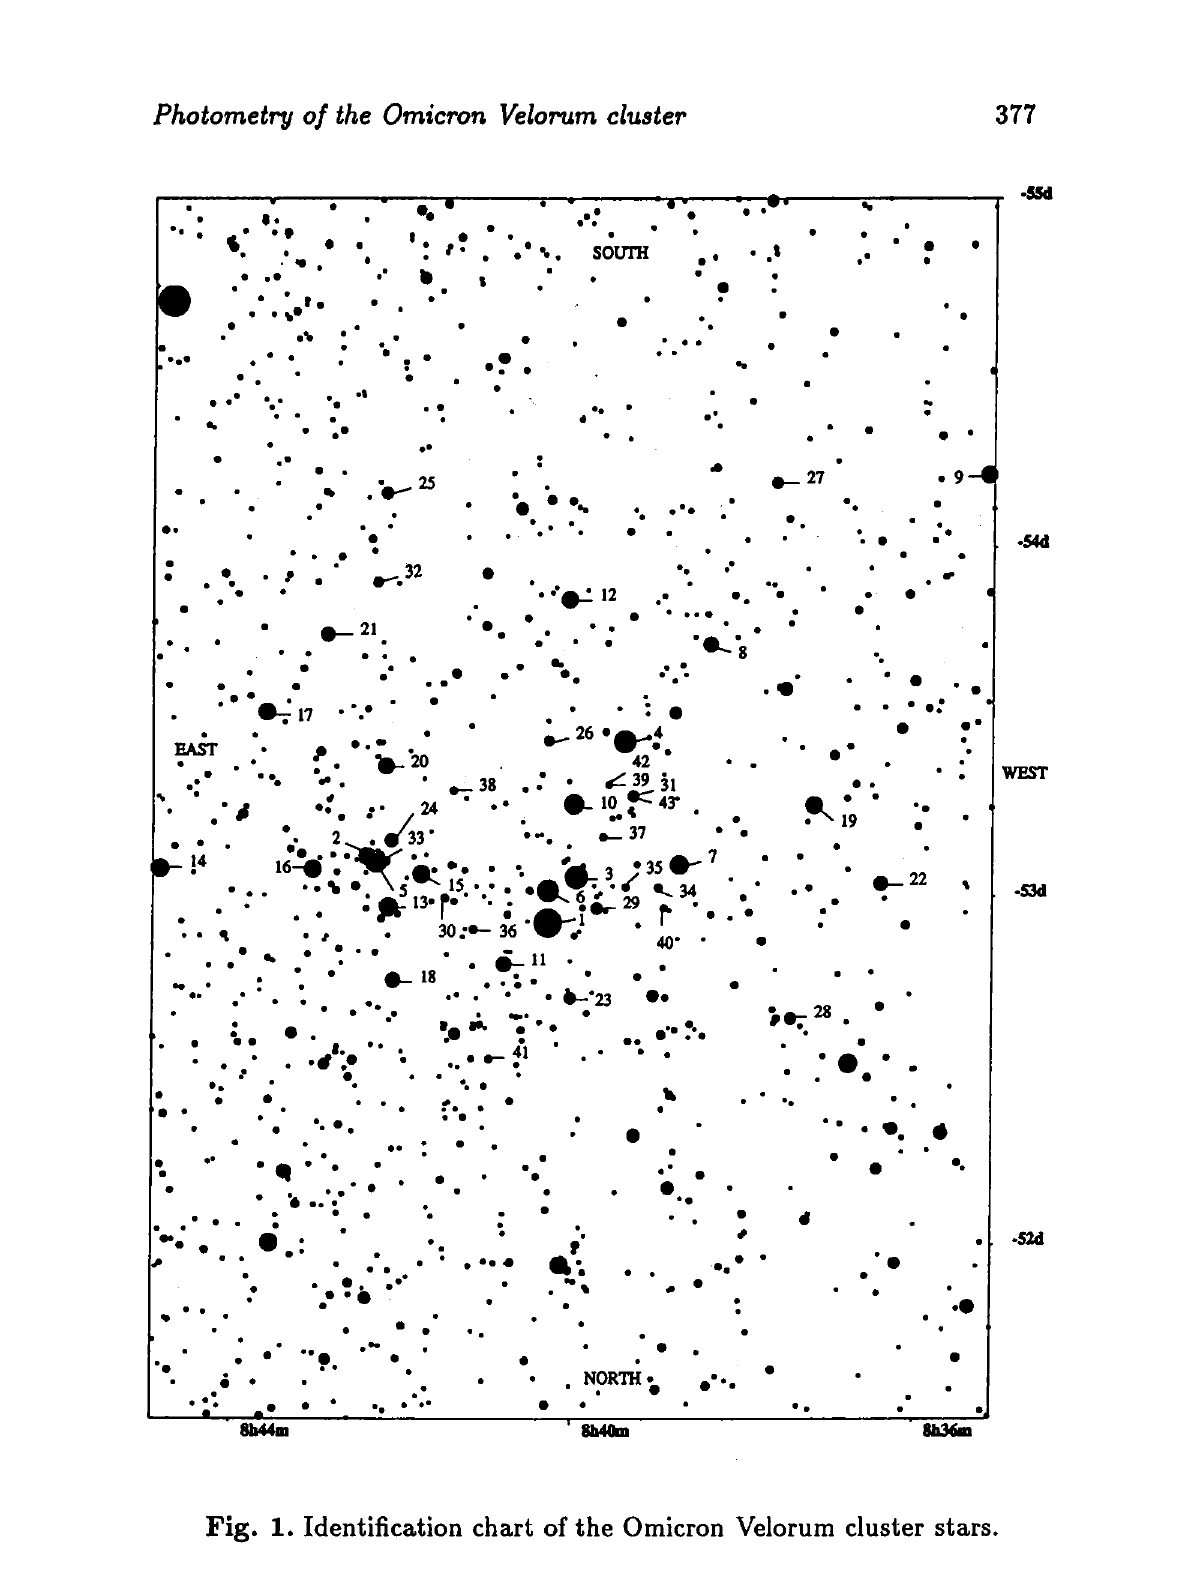
Fig. 1. Identification chart of the Omicron Velorum cluster